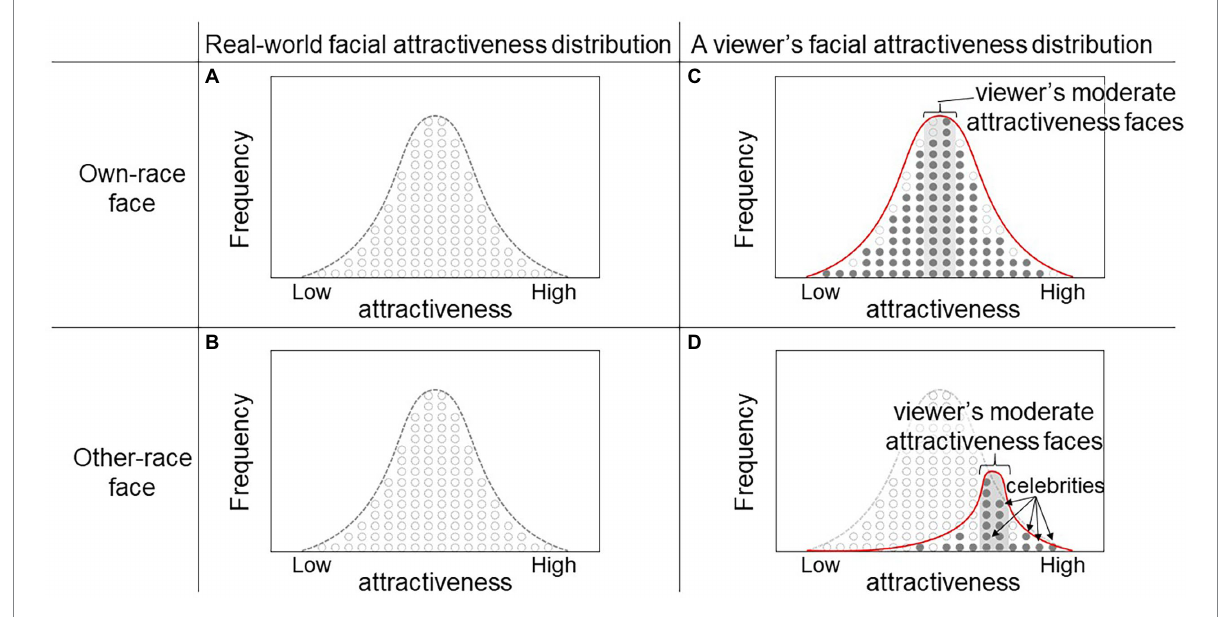
FIGURE 1 Distribution of real-world own-race (A) and other-race (B) facial attractiveness ratings. (C) Distribution (red solid line) of facial attractiveness ratings based on the viewer’s own experience. The ordinate represents the frequency and the abscissa represents facial attractiveness ratings. Filled circles represent encountered individuals. Own-race moderately attractive faces are viewed most frequently. (D) The distribution (red solid line) of other- race facial attractiveness ratings is skewed toward high attractiveness because the viewer’s experience is limited to attractive faces, such as celebrities. A viewer sees other-race highly attractive faces more often than moderately attractive